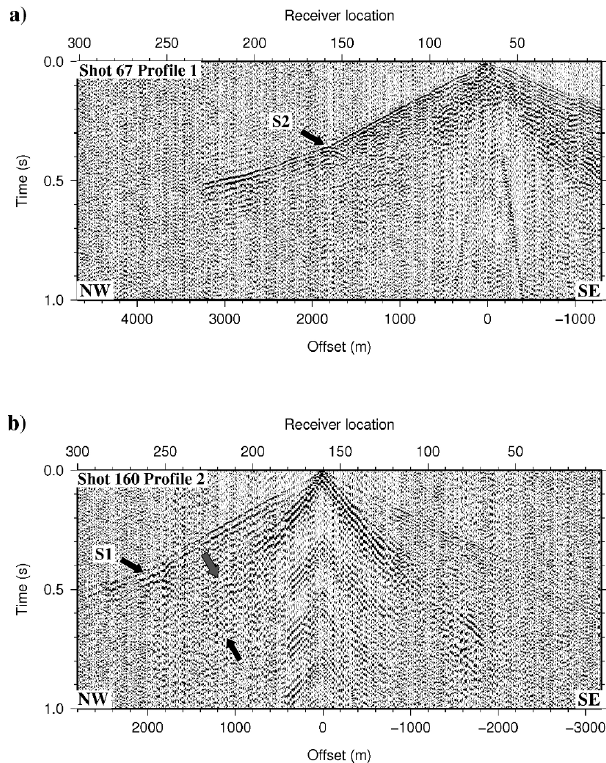
Fig. 8. P-S converted reflections (S2 and S1) in raw shot-gathers on both S.P. 1 (a) and S.P. 2 (b) . Dark gray arrow indicates where surface waves